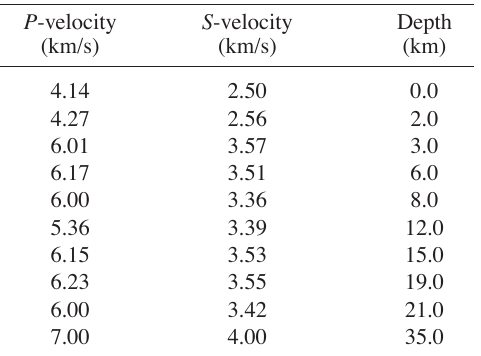
Table I. P- and S -velocity